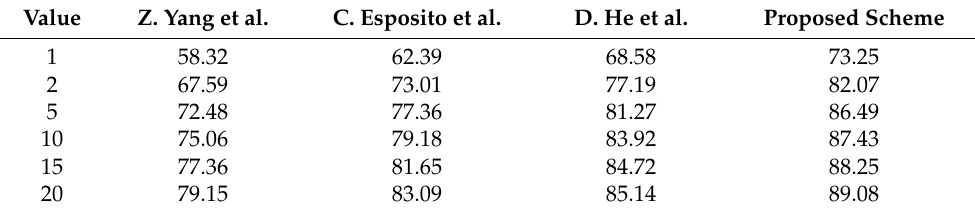
Table 4. The Efficiency of IoT information processing in subnet gateway servers. Units: